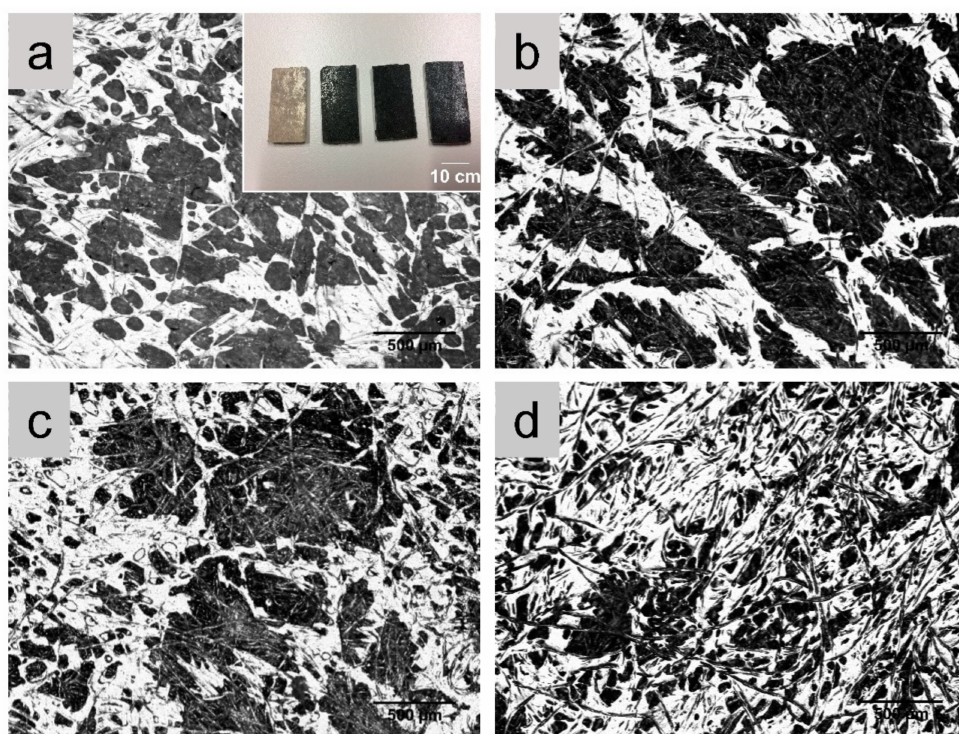
Figure 4. Optical images on the surfaces of the consolidated cotton/PLA composite and GNP-coated cotton/PLA composites. ( a ) CP; ( b ) CP_0.19GO; ( c ) CP_0.38GO; ( d ) CP_0.51GO. The inset in ( a ) is the photo of the four types of consolidated composite specimens sequentially.